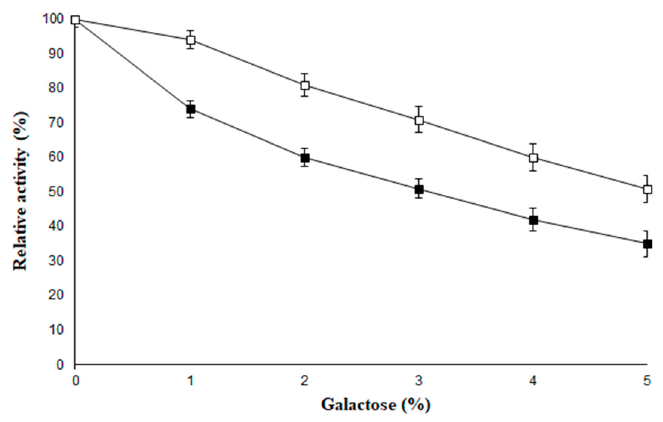
Figure 7. Effect of galactose on soluble and immobilized β -galactosidase. For symbols, please refer to the legend of Figure 5.